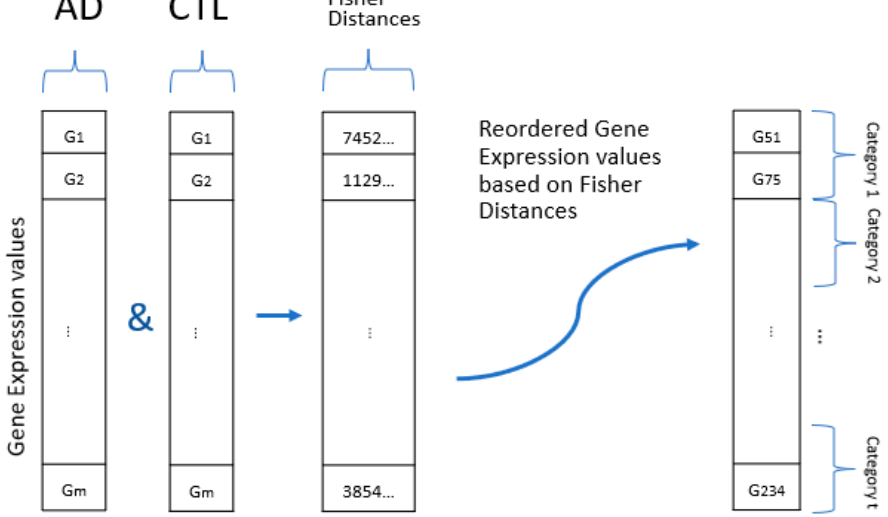
Figure 1. Labeling the genes by Fisher distance measurement. The two blocks on the graphic represent a gene expression array for the AD and CTL classes. The third block shows the Fisher distances of each gene, and the last block shows the categorization of the genes according to Fisher distances.